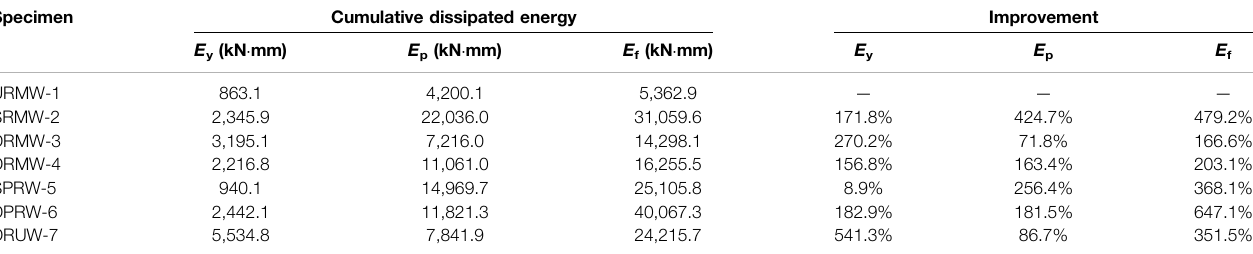
TABLE 6 | Cumulative energy dissipation in each stage of the specimens. Specimen